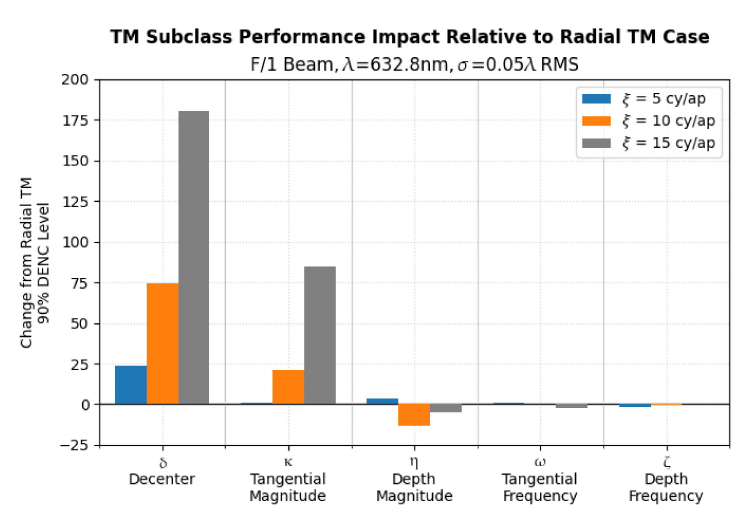
Figure 11. Performance impact of TM subclass characteristics. Metric was judged with respect to the 90% encircled energy radius for radial tooling marks of radial frequency ξ . Range for each parameter is identified in Table